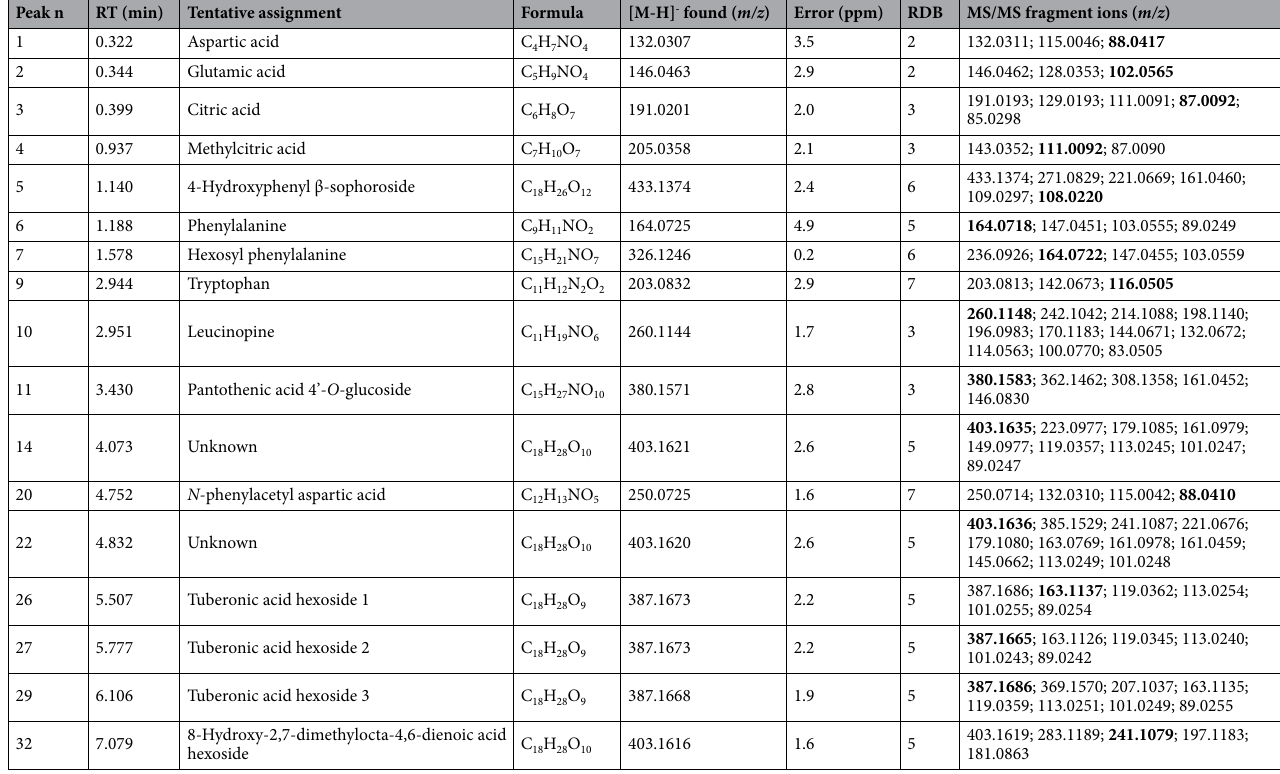
Table 1. UHPLC-ESI-QqToF/MS and MS/MS data useful for tentative identification of non-phenolic compounds in hydro-alcoholic extracts (base peaks in MS/MS spectra are reported in bold; RT = retention time; RDB = ring and double bond value). MS/MS spectra are reported as Supplementary